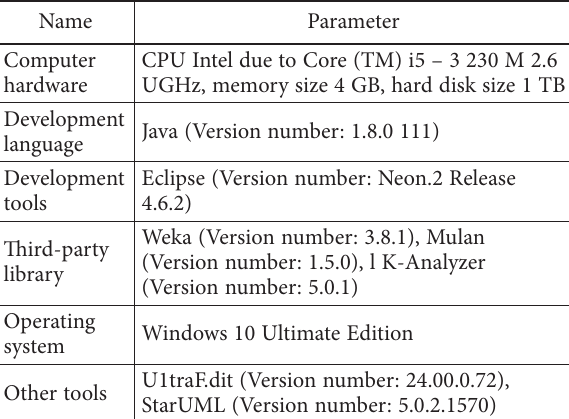
Table 2. Simulation experiment environment